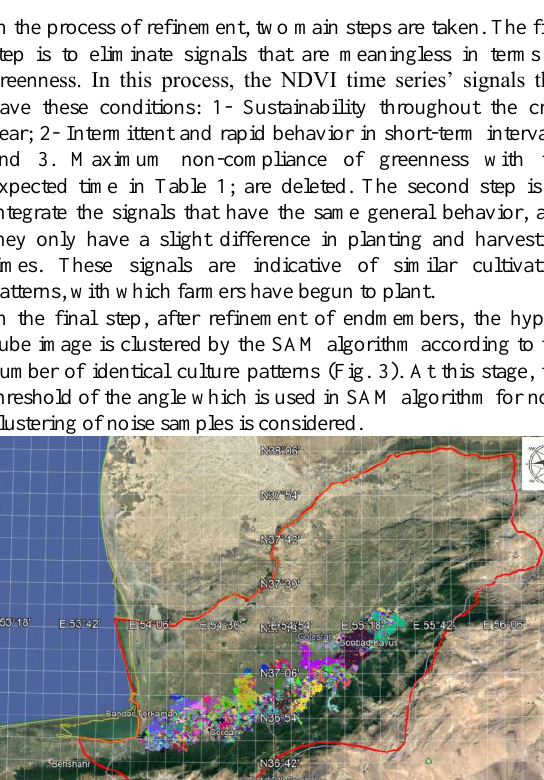
Figure 2. Major cultivation pattern of agricultural products in Golestan province